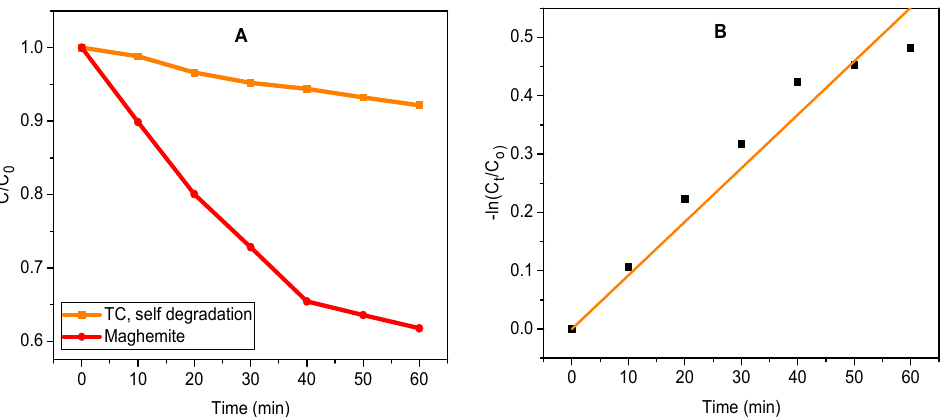
Figure 8. The concentration of TC with irradiation time in the presence and absence of maghemite nanoparticles ( A ) and pseudo-first-order kinetics ( B ) of TC in the time course of photodegradation. (cid:16) (cid:17) C t The plot of − ln versus t for pseudo-first-order is shown in Figure 8B. Here C 0 C 0